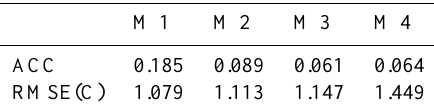
Table 1. The average of the ACC and the